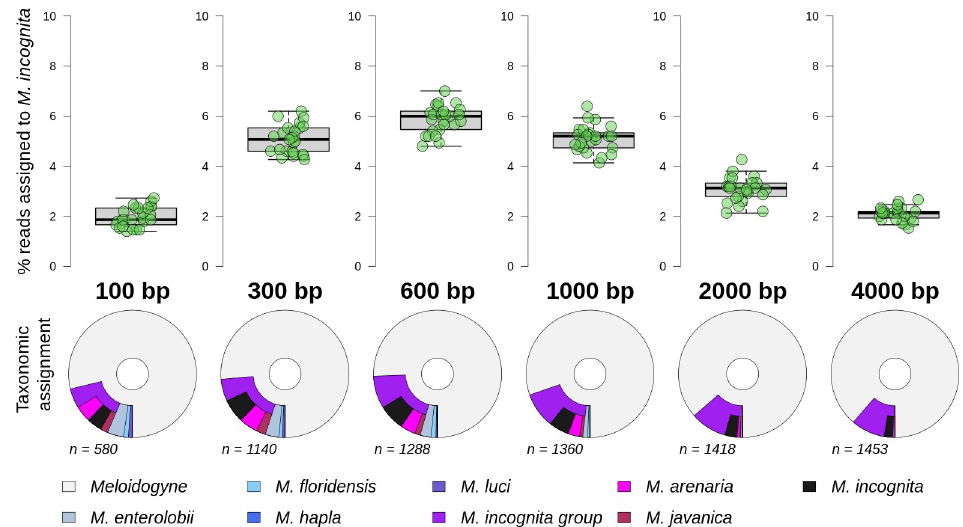
Fig 4. Taxonomic assignment success of 1500 M . incognita reads varied by read length. Top panel shows the percentage of reads assigned to species level from 100 to 4000 bp. Each treatment has 25 replicates. Lower panel shows a single replicate example of taxonomic assignment of reads ( n ) to the genus Meloidogyne and lower taxonomic levels. For each chart the distance from the inner circle represents NCBI taxonomic lineage length; the inner segment is genus level assignment, the second segments are species level assignments (including the MIG species group). MIG species populate the outermost segments, internal to the MIG species group assignments. Segment widths denote proportion reads assigned to that taxonomic level or